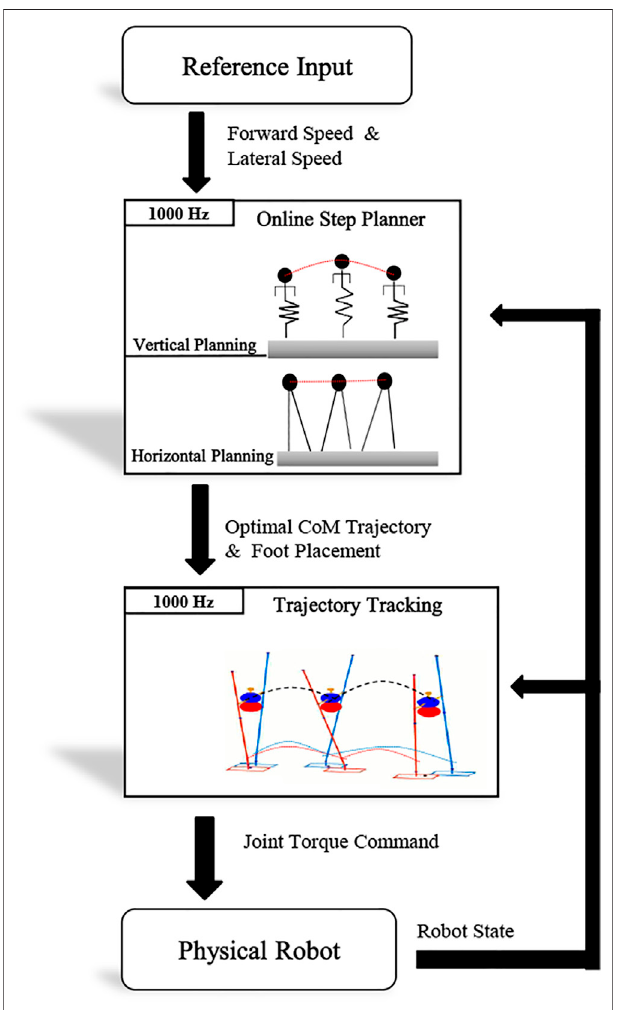
FIGURE 3 | Hierarchical controller with the execution frequency of each level. The high-level trajectory planner takes the desired velocity as input and generates the optimal CoM trajectory along with the foot placement. The low- level whole body controller (Feng et al., 2015; Herzog et al., 2015) considers full dynamics of therobotand tracks the trajectory at a frequency of 1 kHz.